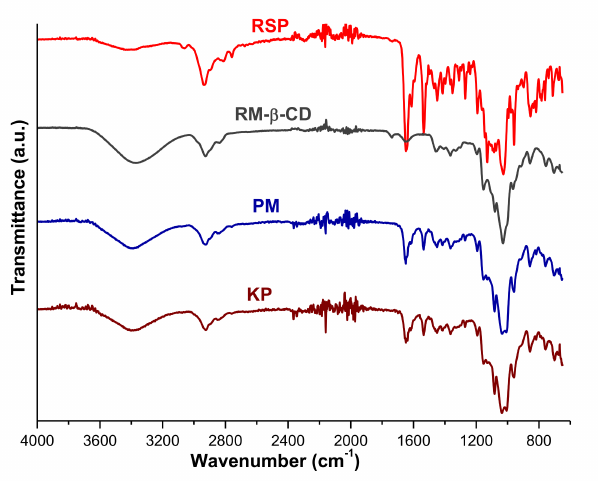
Figure 6. Universal-attenuated total reflectance Fourier transform infrared (UATR-FTIR) spectra of RSP, RM- β -CD, and RSP/RM- β -CD binary systems PM and KP. The UATR-FTIR spectrum of RSP presents characteristic bands at 3063, 2936, 2812, 2759, 1648, 1534, 1449, 1414, 1352, 1130, 1027, 959, 854, and 816 cm − 1 that have